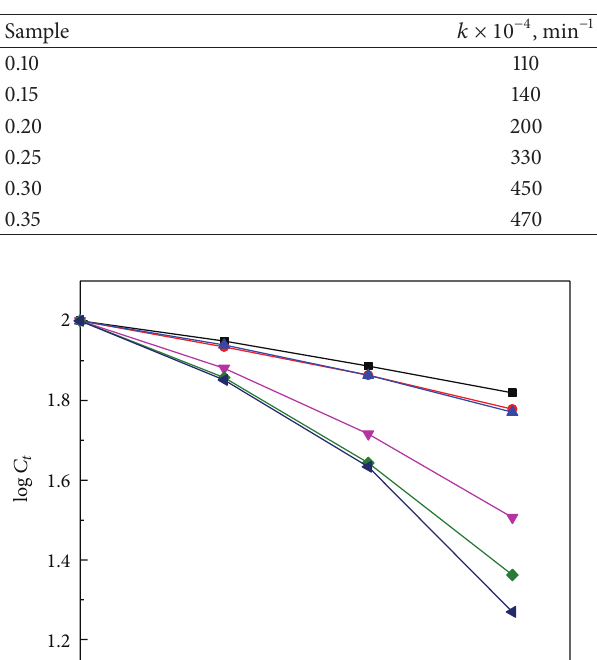
Table 2: Observed rate constants of CN − degradation using ZrO and Pt/ZrO -SiO. SiO 2 2